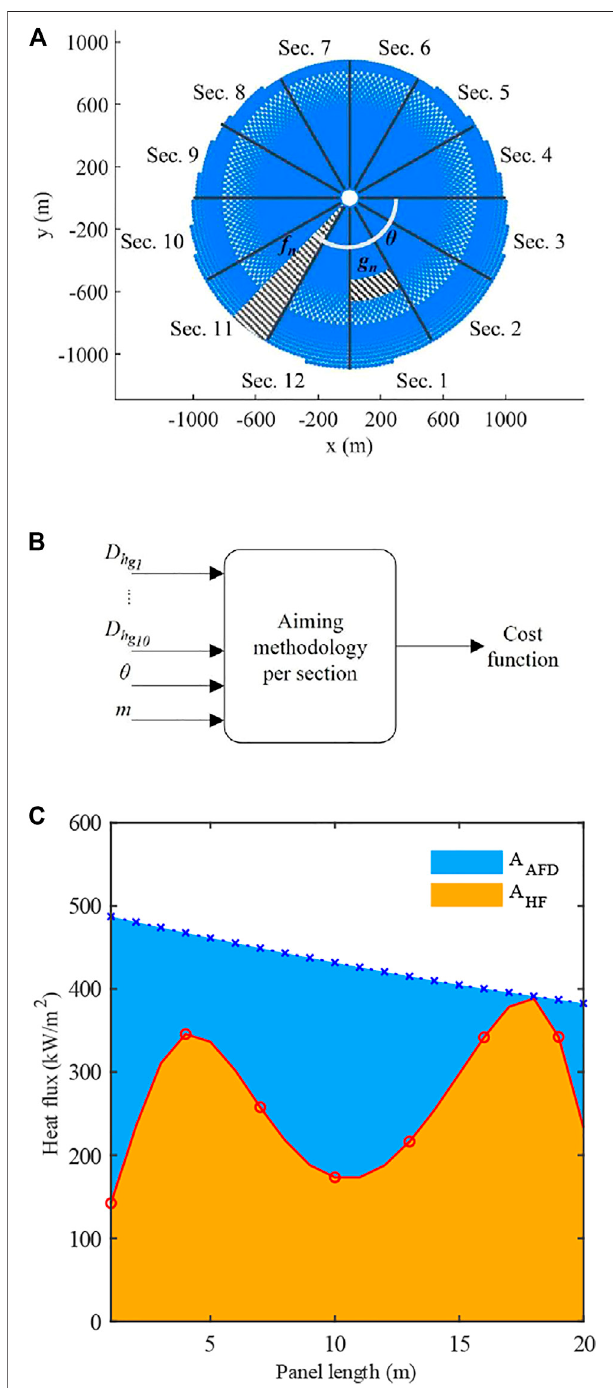
FIGURE 5 | (A) Examples of subgroups g n and f n used for the optimization of variables D h and ud (B) General scheme of inputs and frac outputs for the optimization of one section of the solar fi eld (C) Graphical representation of the areas used for the cost function.